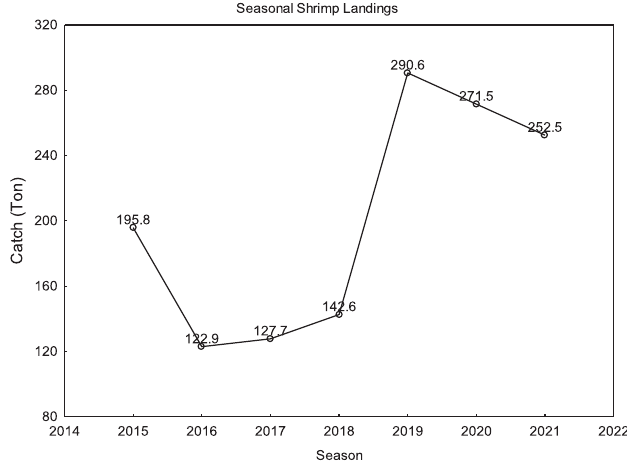
Fig. 1. The annual catch of “ large shrimps ” category, i.e. Penaeus semisulcatus and Penaeus japonicus in the Gulf of Suez, Egypt. Total numbers of catch in the period between 2014 – 2022 are shown in tons. Egypt (GAFRD), Suez branch